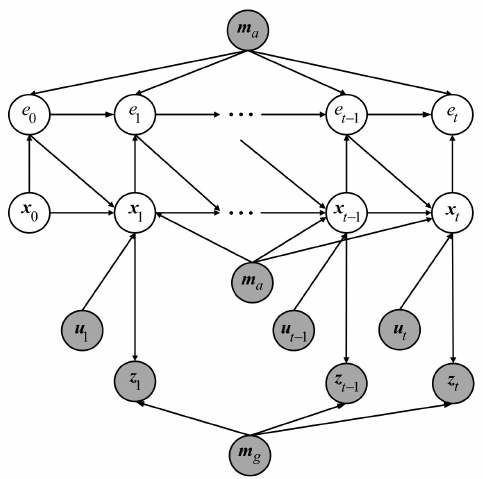
Figure 5. Improved DBN for localization problem. The AGM node ( m g ) and the cumulative ambiguity error node ( e t ) are